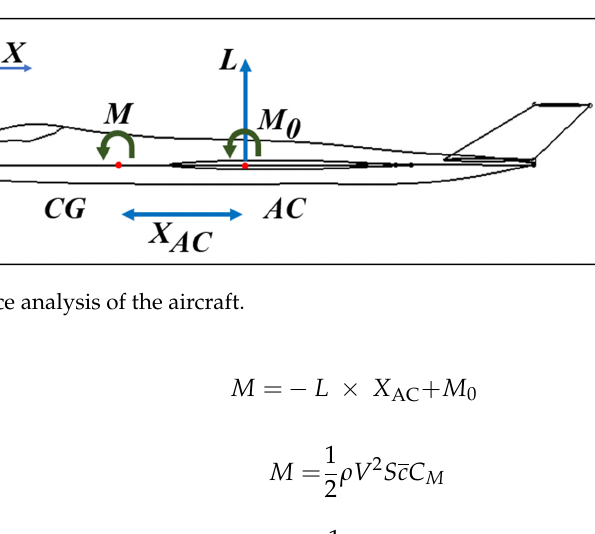
Figure 4. Aerodynamic coefficients calculated by CFD: ( a ) lift coefficient; ( b ) pitch moment coefficient; and ( c ) hinge moment.